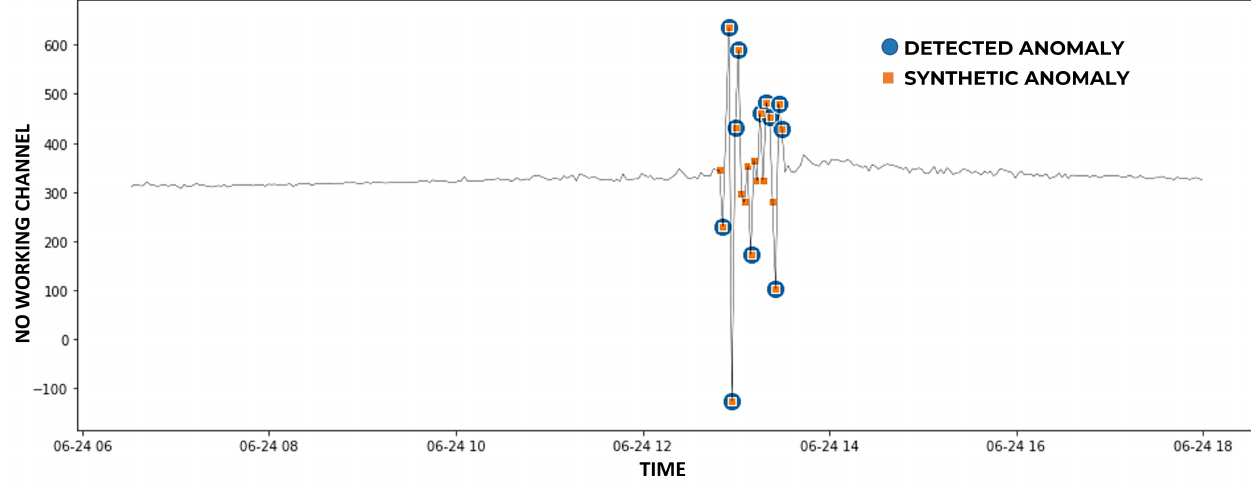
Figure 4. Variance synthetic anomalies detected by FFIDCAD for NO from 6 a.m to 6 p.m. of